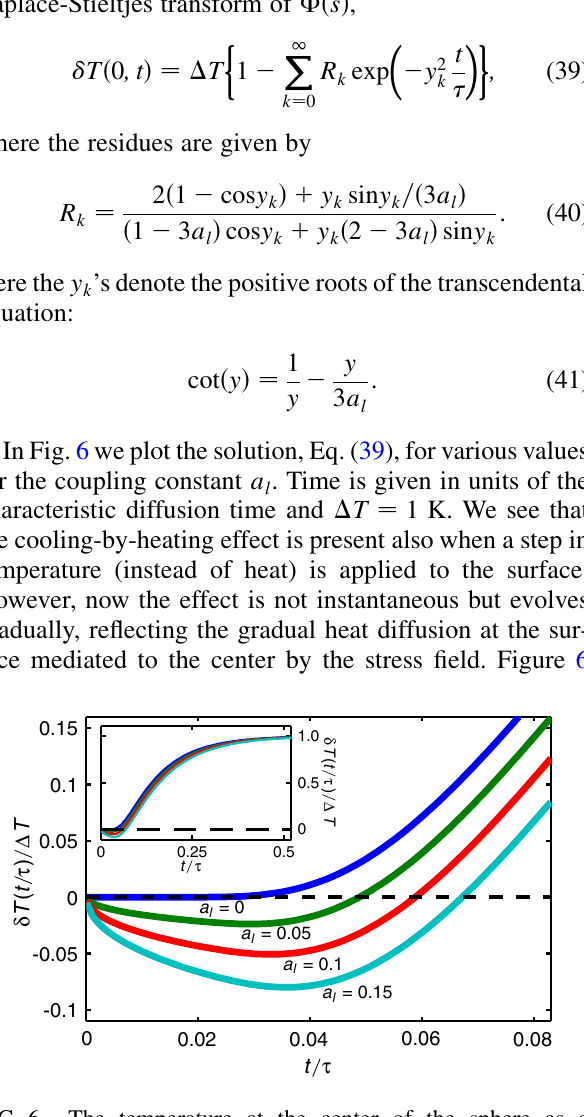
FIG. 5. The (cid:12)(cid:12) component of the stress tensor, 1 (cid:2) 3 1 F , as a function of time scaled with the initial stress (cid:6) 1 2 There is an initial adiabatic positive step up in (cid:6) the sphere. The regions that have been reached by the incoming diffusive heat at a certain point in time experience a negative (cid:12)(cid:12) -stress component since the inner unheated regions pull the outer heated regions inwards.